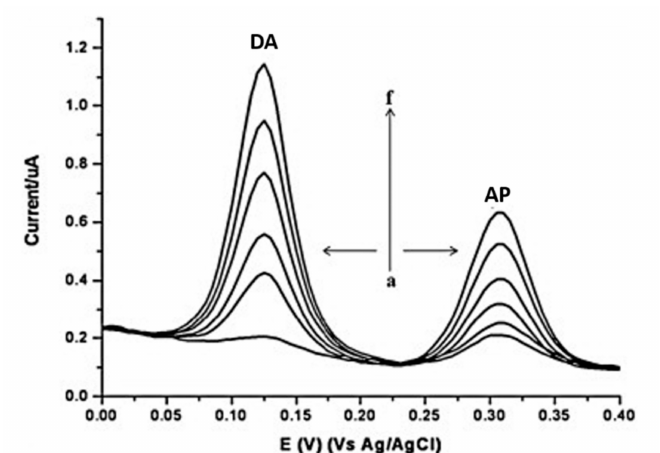
Figure 9. DPV voltammograms of increasing concentrations of DA and AP at a f-MWCNT modified electrode. Reprinted with permission [49].